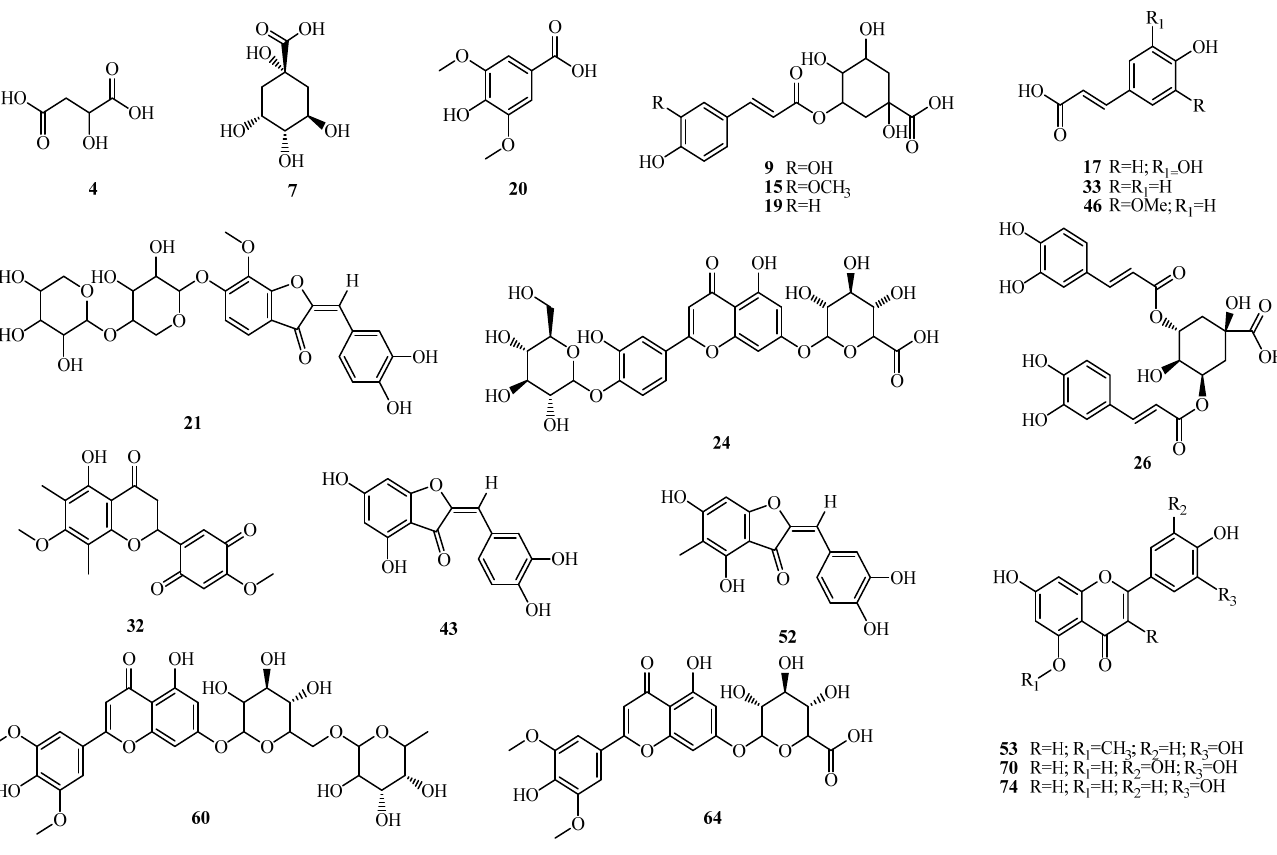
Figure 2. Representative structures of major metabolites identified in CLEE and peak names follow the numbers stated in Table 1.